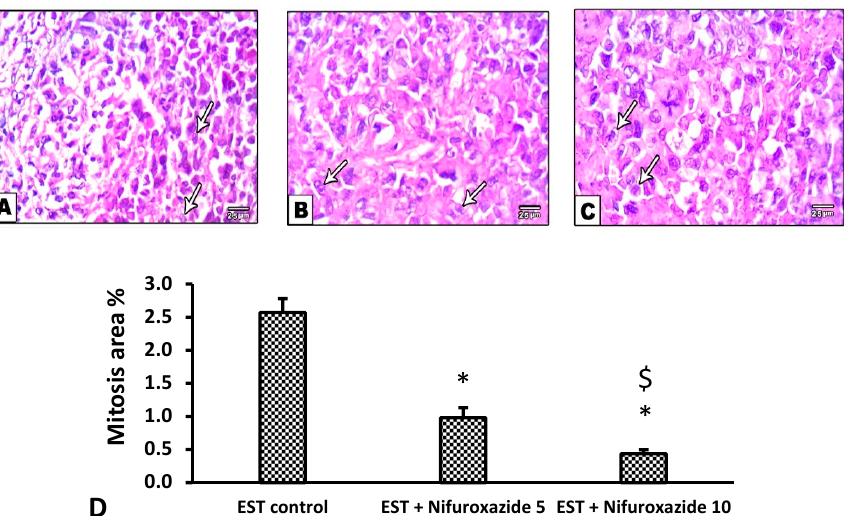
Figure 8. Microscopic pictures of H&E stained sections from tumor masses showing extensive areas of mitosis. ( A ) The EST group shows extensive mitosis (arrows), while a marked reduction in mitosis was observed in the EST + Nifuroxazide 5 or 10 treated groups ( B , C ). X: 400, bar 25. ( D ) Column chart representing the percentage of mitotic area, data are mean ± S.D. and compared at P less than 0.05. * Versus the EST control, $ Versus the EST + Nifuroxazide (5 mg/kg) group. EST: Ehrlich solid tumors.